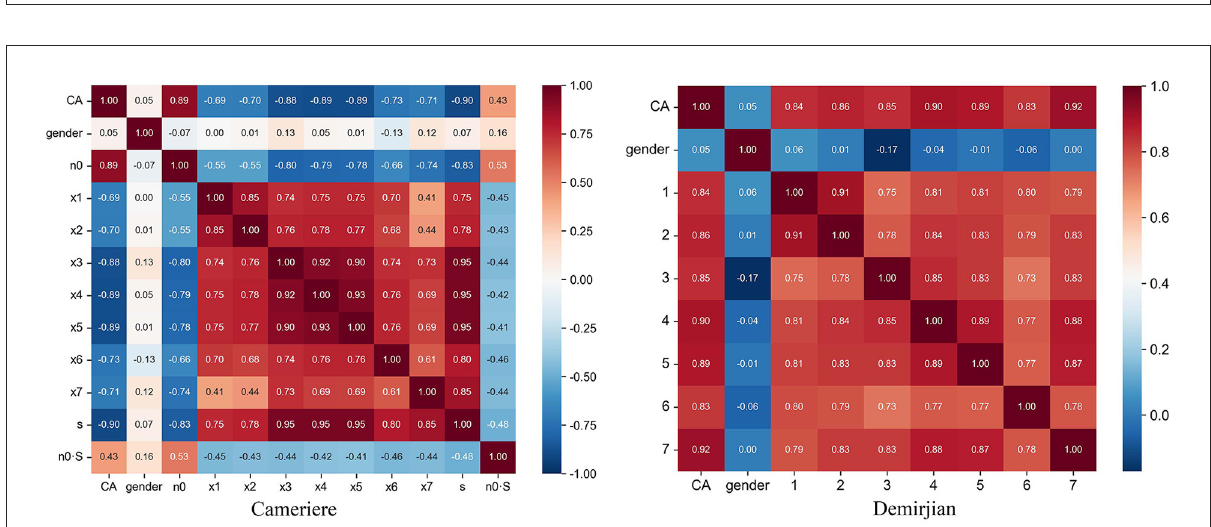
FIGURE4 Heatmap of the correlation coefficient between the variables. (Left) The variables of the Cameriere method, gender (g), the normalized measurements of the seven permanent developing teeth on the left mandible (X i , i = 1, …,7), the sum of the normalized open apices (s, s = X 1 + X 2 + … + X 7 ), the number of teeth with complete root development (N 0 ) and the first-order relationship between s and N 0 (s · N 0 ). (Right) The variables of the Demirjian method, gender (g) and the assessment grade of the seven permanent teeth.